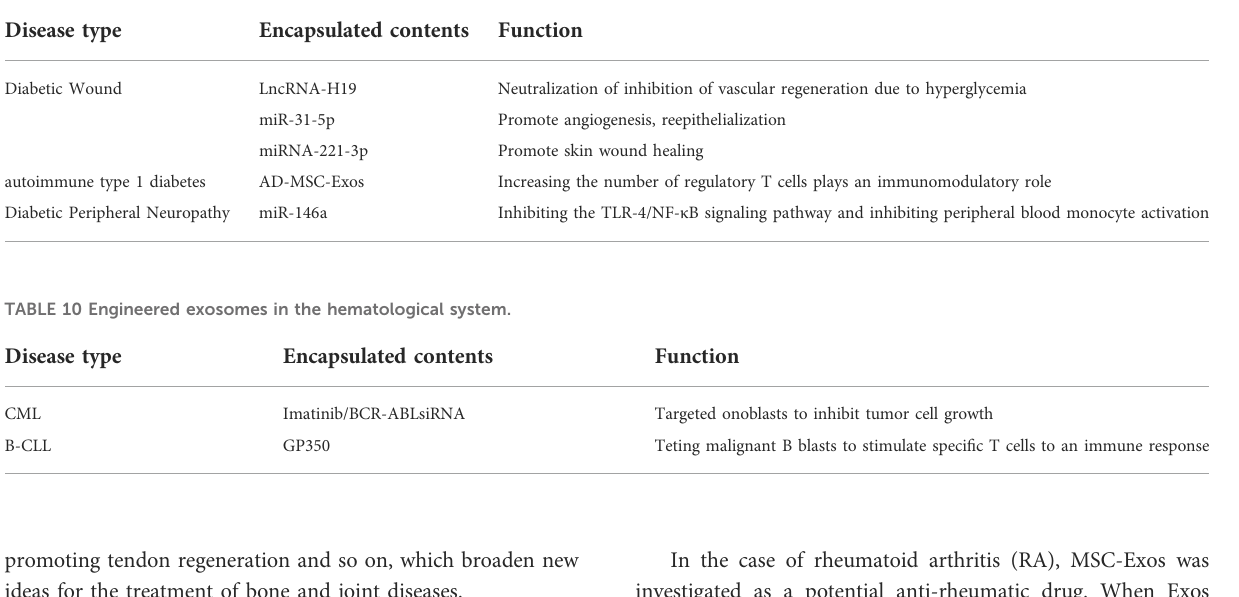
TABLE 9 Engineered exosomes in the endocrine system.